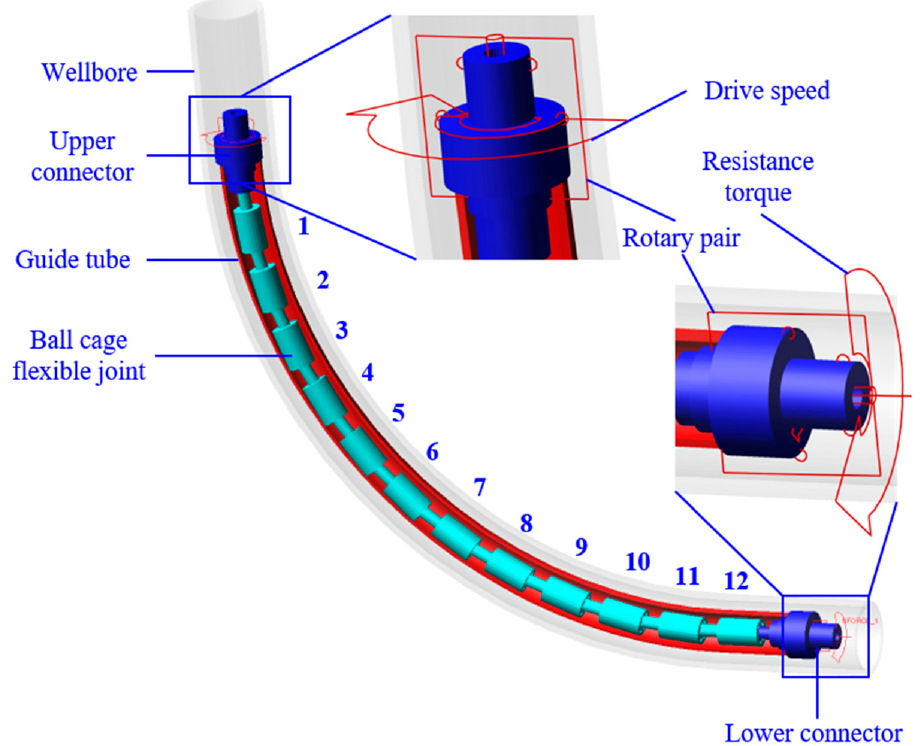
Figure 8. Multi-body dynamics model flexible drill pipe.